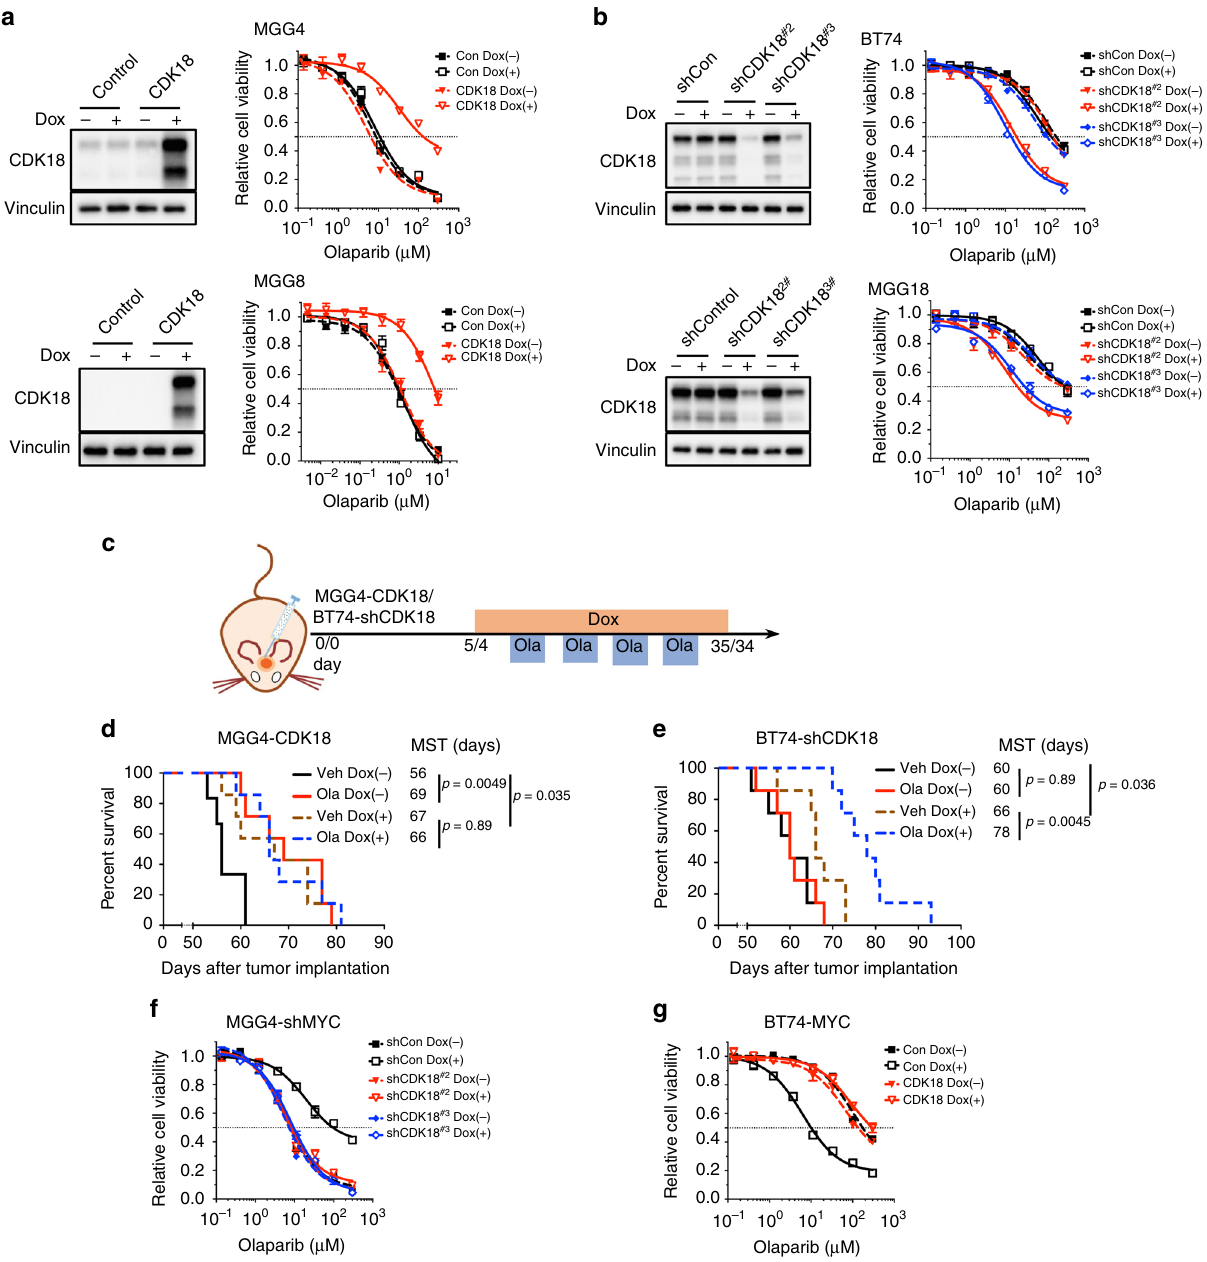
Fig. 3 Cyclin-dependent kinase 18 (CDK18) regulates MYC/MYCN-induced poly(ADP-ribose) polymerase inhibitor sensitivity in glioblastoma stem-like cells. a , b Effect of CDK18 expression on olaparib sensitivity. (left) Western blots showing CDK18 overexpression or knockdown with ( + ) or without ( − ) doxycycline (Dox). (right) Olaparib dose – response curves. a MGG4-control (Con)/MGG4-CDK18 (upper) and MGG8-control (Con)/MGG8-CDK18 (lower). b BT74-shControl (shCon)/BT74-shCDK18 (upper) and MGG18-shControl (shCon)/MGG18-shCDK18 (lower) (shCDK18; two independent sequences), with ( + ) or without ( − ) Dox. c Treatment schedule for d , e . Details as in Fig. 1g. d , e Kaplan – Meier survival curves of mice bearing orthotopic MGG4-CDK18 ( d ) or BT74-shCDK18#2 ( e ) xenografts treated with olaparib (Ola) or vehicle (Veh) with ( + ) or without ( − ) Dox. MST median survival time. Vertical lines indicate p value comparisons (log-rank test). f , g Olaparib dose responses in MGG4 with knockdown of MYC alone (MGG4-shMYC- shCont) and with CDK18 (MGG4-shMYC-shCDK18 (two independent sequences) ( f ) or BT74-overexpressing MYC alone (BT74-MYC-Con) and with CDK18 (BT74-MYC-CDK18) ( g ), with ( + ) or without ( − ) Dox. Western blots are shown in Supplementary Fig. 6. Data normalized to control and mean